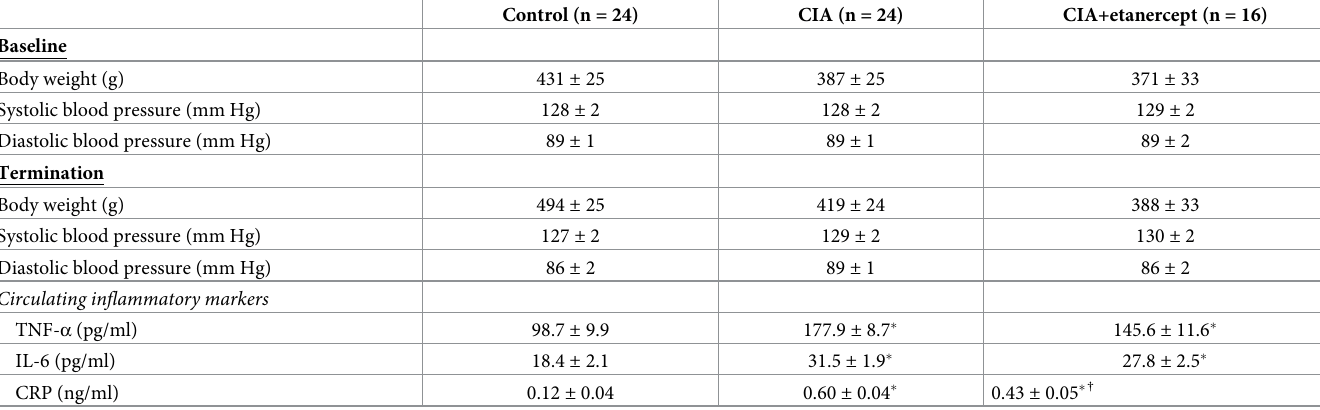
Table 1. Body weights, food intake and tail-cuff blood pressure at baseline and